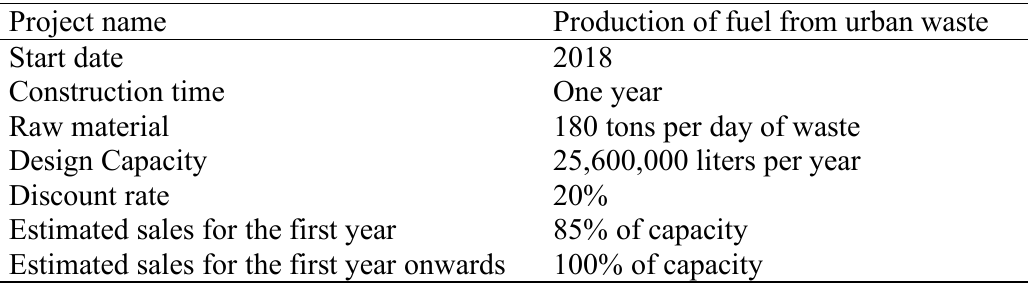
Table 1. Costs of Construction